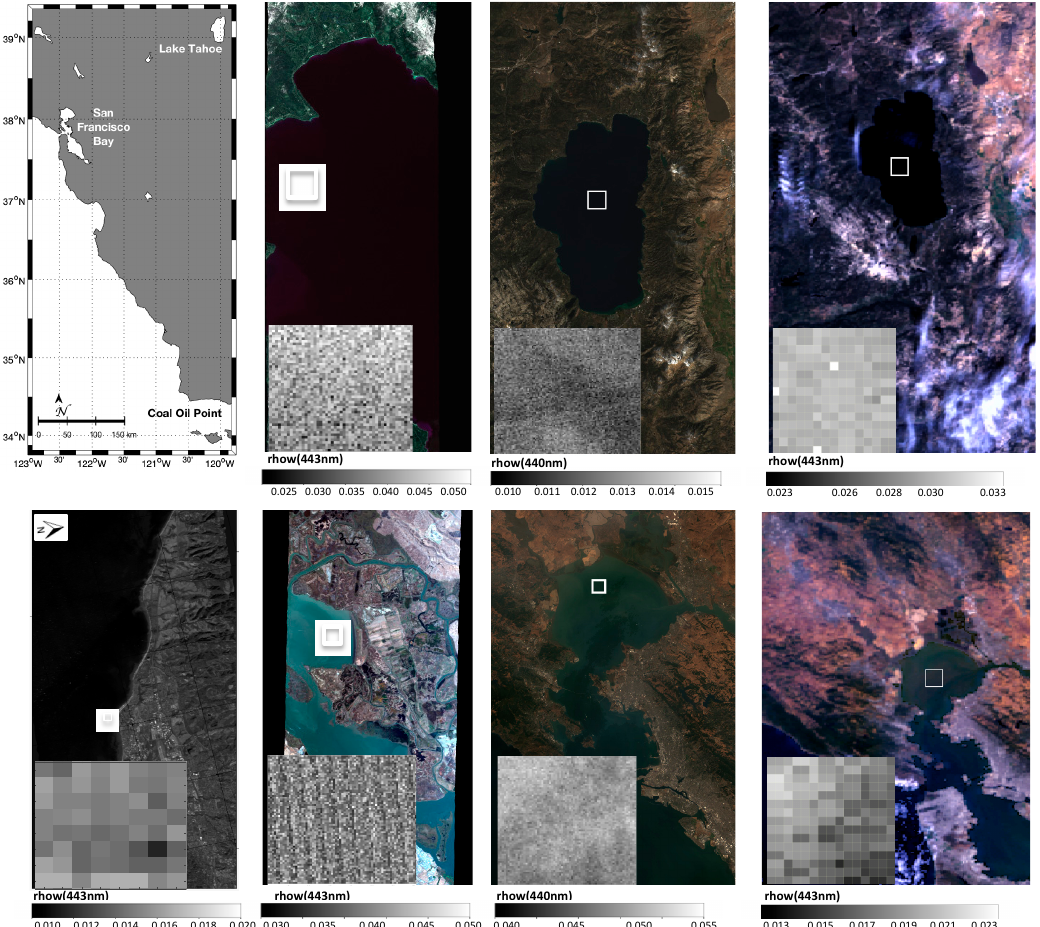
Figure 2. Imagery from Lake Tahoe, San Francisco Bay, and Coal Oil Point (California, USA) were used for analysis. Representative examples of the truecolor (RGB) regions are shown, with the white boxes denoting the data used for SNR calculations. The inset (greyscale) boxes show the data used for a representative wavelength in the blue region of the spectrum. Top row, left to right: map of the region; Lake Tahoe from AVIRIS, OLI, MSI. Bottom row: Coal Oil Point from AVIRIS; Grizzly Bay from OLI; San Pablo Bay from MSI; San Pablo Bay from OLCI.